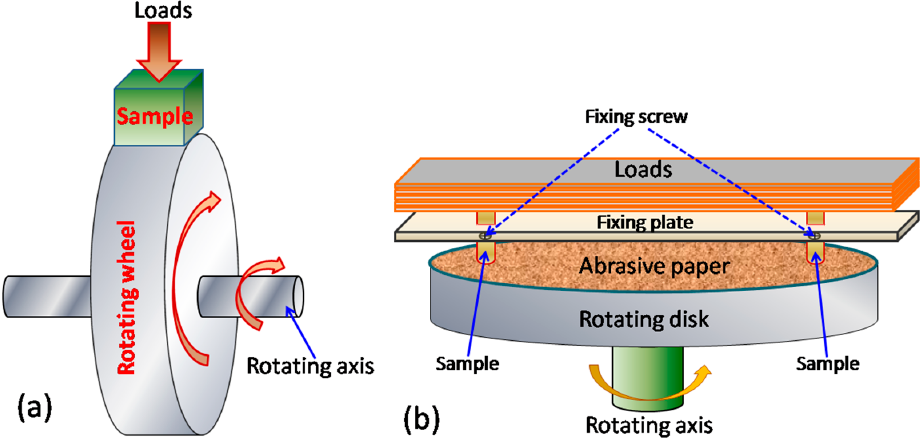
Figure 1. Schematic illustration of ( a ) block-on-wheel dry sliding wear and ( b ) abrasive wear tester.